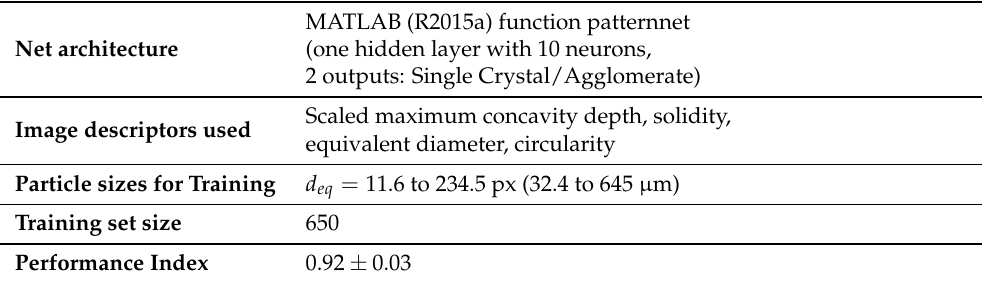
Table A2. ANN based on [15]: architecture, training data and performance. The images were taken with QICPIC/LIXELL wet dispersing system (Sympatec, QICPIC R02, camera resolution: